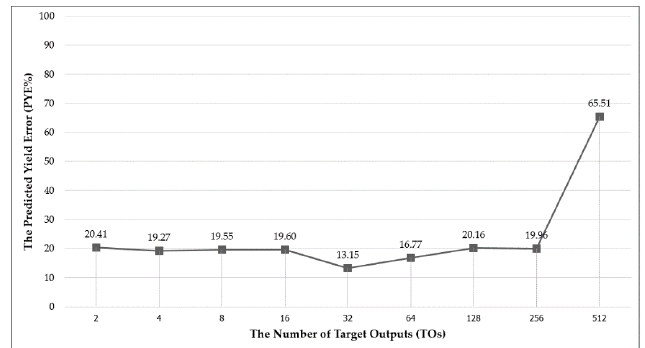
Figure 11. Initial instance of the fully populated trend graph of TOCG numbers and corresponding PYE rates, before the start of the bisection method.